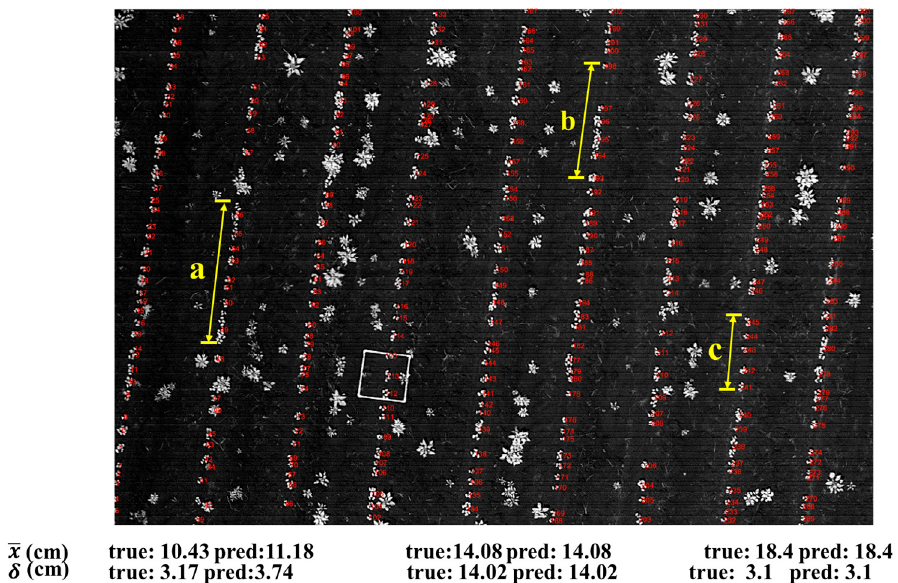
Figure 12. Examples to illustrate of the mean seedling spacing and standard deviation. The true mean and standard deviation were calculated based on the manual count of ROIs. The estimated mean and standard deviation were calculated based on the estimated cotton stand numbers of ROIs. The ‘a’, ‘b’ and ‘c’ were three example positions having different mean seedling spacing and standard deviation.